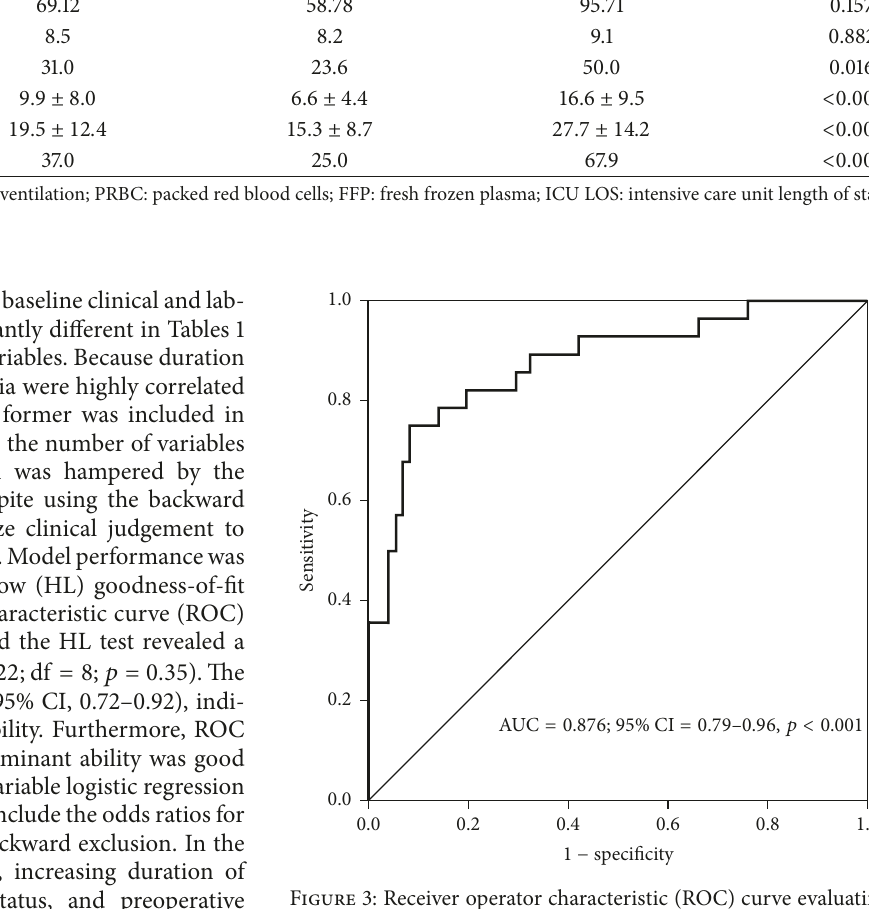
Figure 3: Receiver operator characteristic (ROC) curve evaluating the sensitivity and specificity of the model predicting PPMV. Area under the curve (AUC) for the predictors was 0.87 (95% CI = 0.79 – 0.96 ; 𝑝 < 0.001 ). AUC for the ROC indicates the usefulness of a test (our model) in predicting a binomial outcome (PMV yes/no). A value of 0.87 indicates “good” model predictive